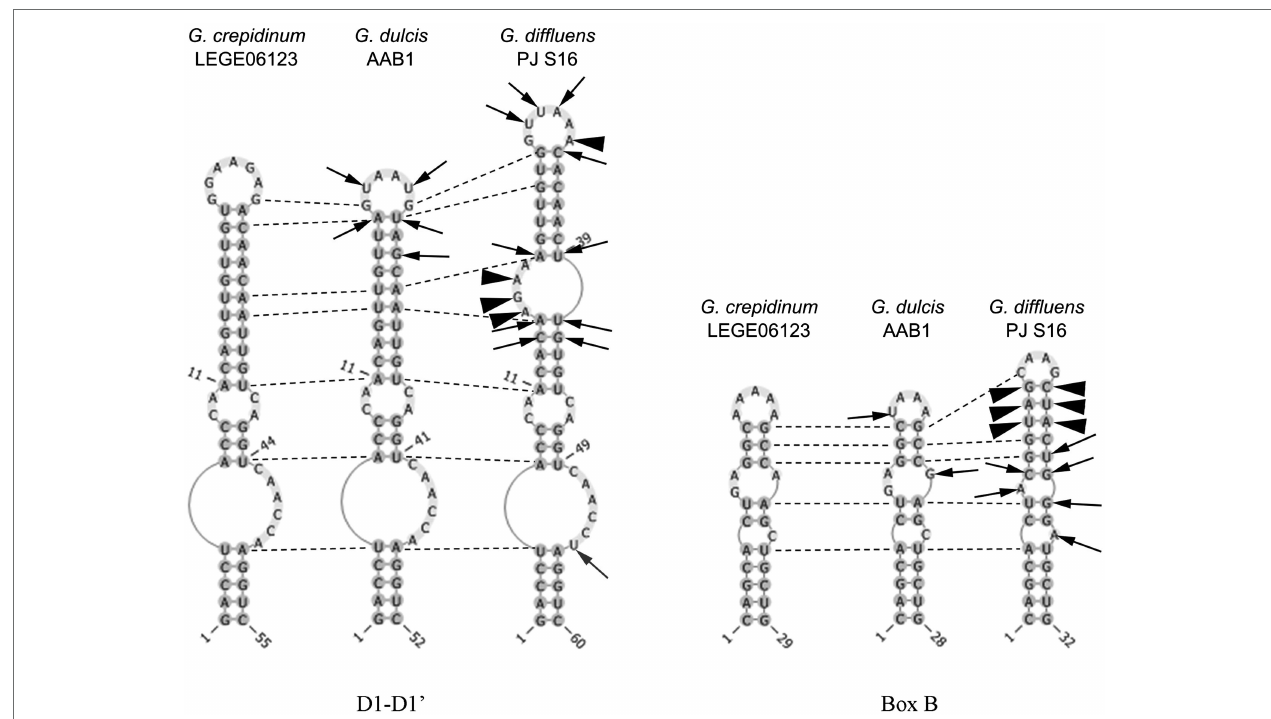
FIGURE 6 | Secondary structure of the main informative helices of the 16-23S ITS region of the inspected species. Differences between strains are presented in comparison with Gloeocapsopsis crepidinum strain LEGE 06123. Arrows show variable bases, arrowheads show insertions/deletions of base pairs, and dotted lines show homological base pairs among